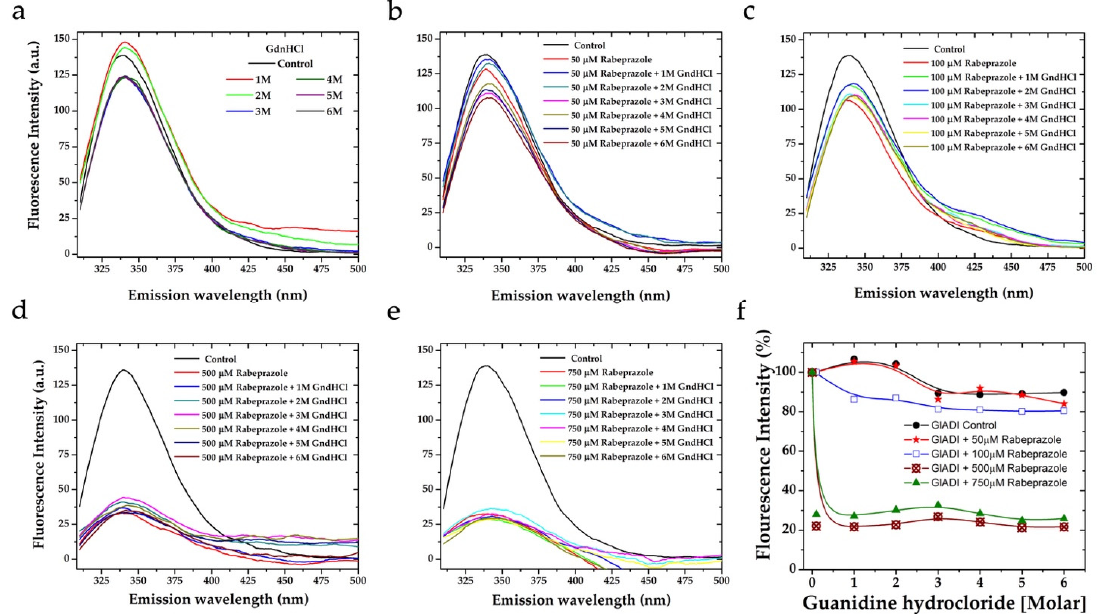
Figure 3. Fluorescence emission spectra of GlADI at rising concentrations of the chaotropic agent guanidine hydrochloride (GdnHCl). The intensity of intrinsic fluorescence of GlADI is almost not decreased by increasing concentrations of GdnHCl tested in a range of denaturing concentrations ( a ), even when rabeprazole 50 μ M ( b ) or 100 μ M ( c ) are added. The intensity of intrinsic fluorescence of GlADI is strongly decreased when rabeprazole 500 μ M ( d ) or 750 μ M ( e ) are added. The overall data show the effects of low and high concentrations of rabeprazole on the intrinsic fluorescence of GlADI in the presence or absence of GdnHCl ( f ).